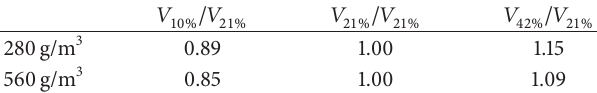
Table 3: Flame speed scaling in the kinetic limit.